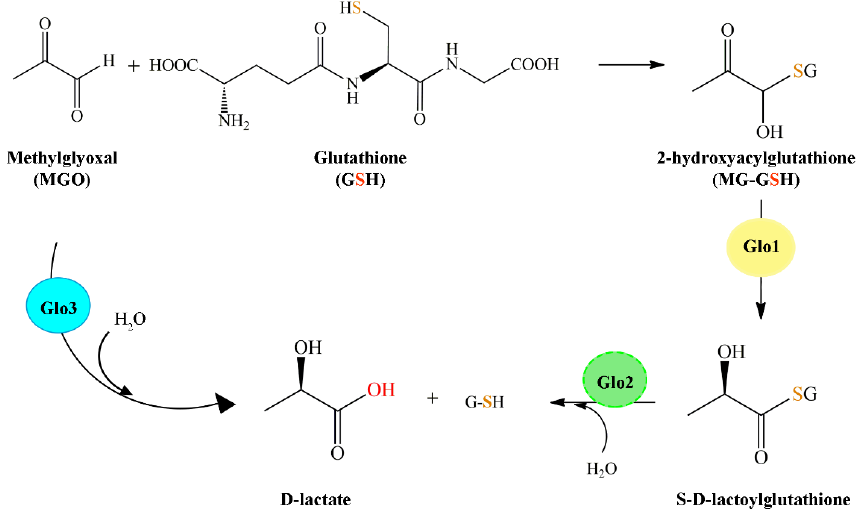
Figure 1. Conversion of methylglyoxal to D-lactic acid by glyoxalases. The GSH-dependent sys- tem is a two-enzyme pathway involving Glo1 and Glo2 enzymes. Glo1 catalyzes the formation of S -D-lactoylglutathione from the non-enzymatically formed hemimercaptal adduct of MGO with GSH, 2-hydroxyacylglutathione (MG-GSH). Glo2 catalyzes the hydrolysis of S -D-lactoylglutathione to D-lactic acid and GSH [43]. The GSH independent system involves a single Glo3 enzyme recently